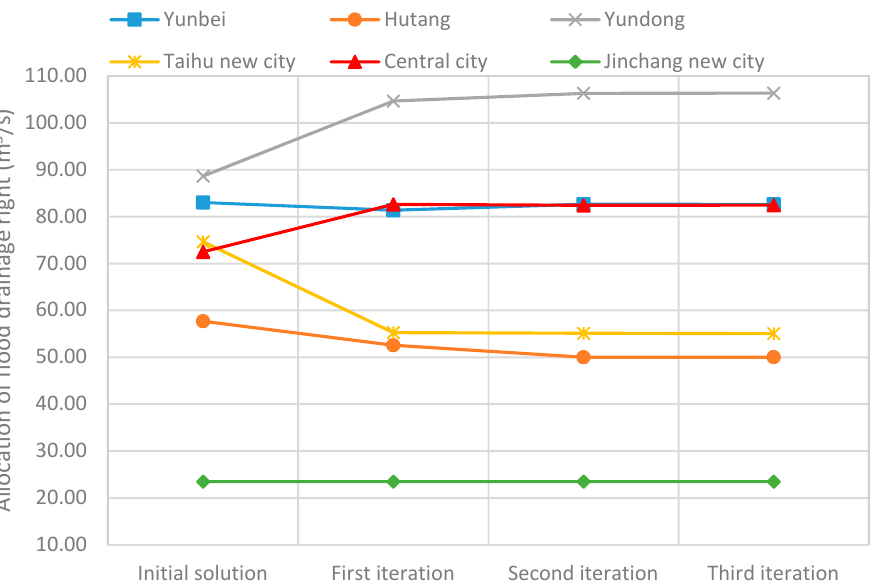
Figure 2. Allocation process of flood drainage right in Sunan Canal.